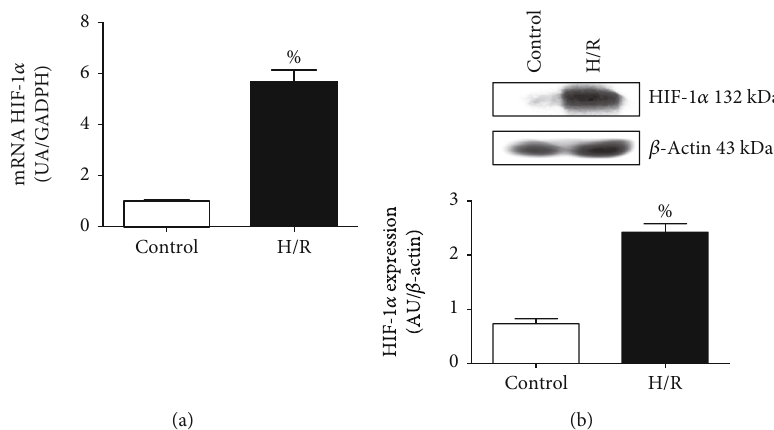
Figure 2: Evaluation of the e ffi ciency of the coverslip assay by quanti fi cation of HIF-1 α in primary cultures of cardiomyocytes undergoing hypoxia/reperfusion (H/R). (a) Quanti fi cation of mRNA HIF-1 α performed through qPCR. HIF-1 α sense: ATACCAGCAGTAACCA GCCG; antisense: CTGTGGCTGAGAGTCCTTCG. (b) Protein expression of HIF-1 α by Western blot and quanti fi ed by densitometric analysis. The values represent the mean ± standard errorof the mean (SEM) of 5 di ff erent experiments. % p < 0 : 05 vs. control. Student ’ s unpaired t -test.